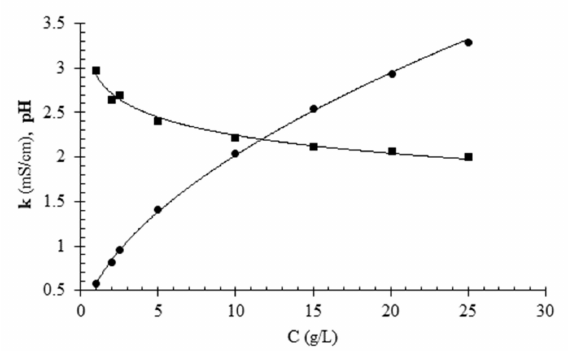
Figure 1. Electric conductivity k ( • ) and pH ( (cid:4) ) at 20 ◦ C of citric acid aqueous solutions as a function of citric acid concentration (C). The symbols refer to experimental data while the continuous lines refer to approximating